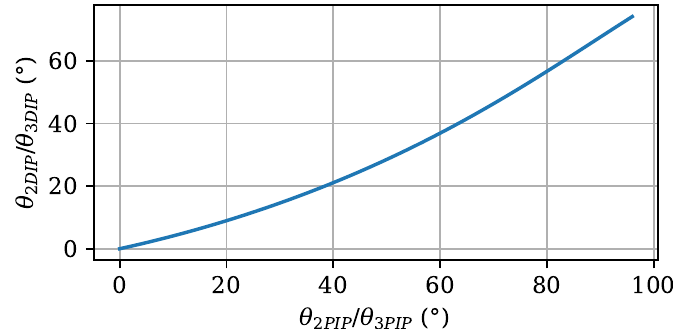
Figure 6. Relation between flexion in PIP and